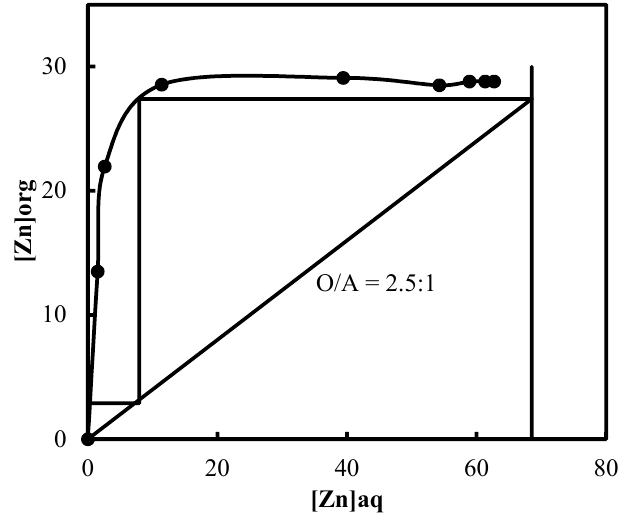
Figure 7. Mc-Cabe Thiele diagram for the solvent extraction of zinc from purified leach solution.